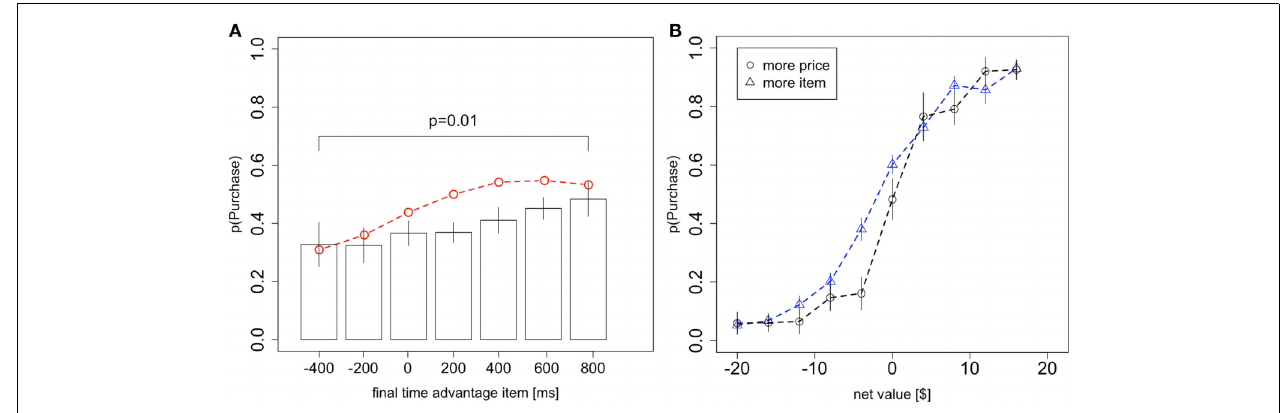
from the aDDM.The p -value is from a one-sided t -test. (B) The probability that the product is chosen as a function of the net value, conditional on whether more time was spent looking at the product or the price in that trial. Bars are standard error bars, clustered by subject.